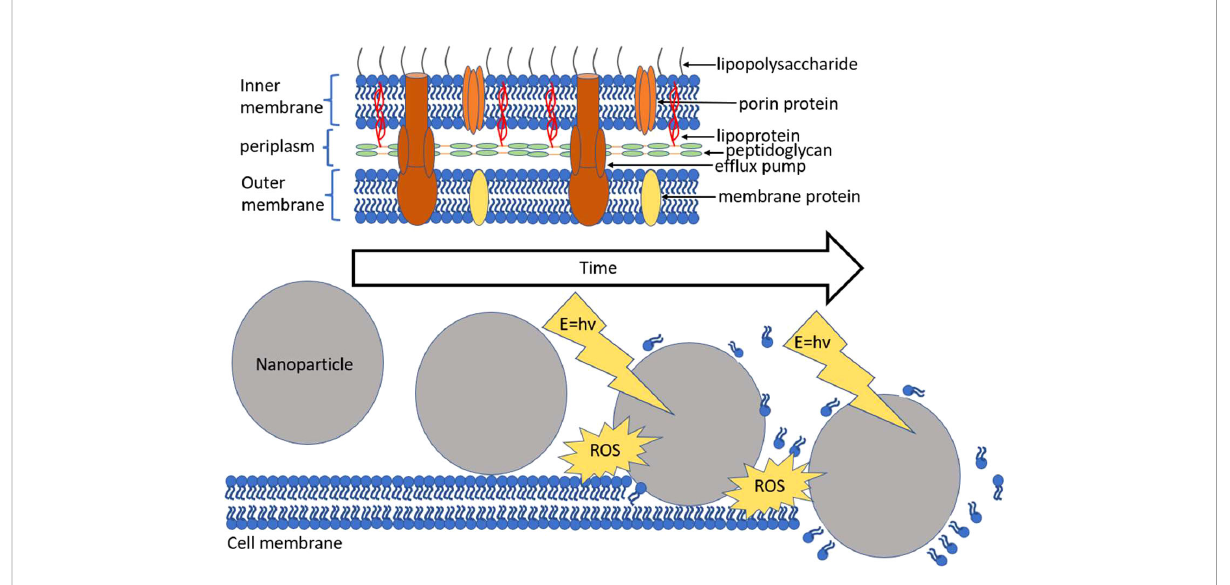
FIGURE 3 Gram-negative cell membrane with a nanophotocatalytic mode of